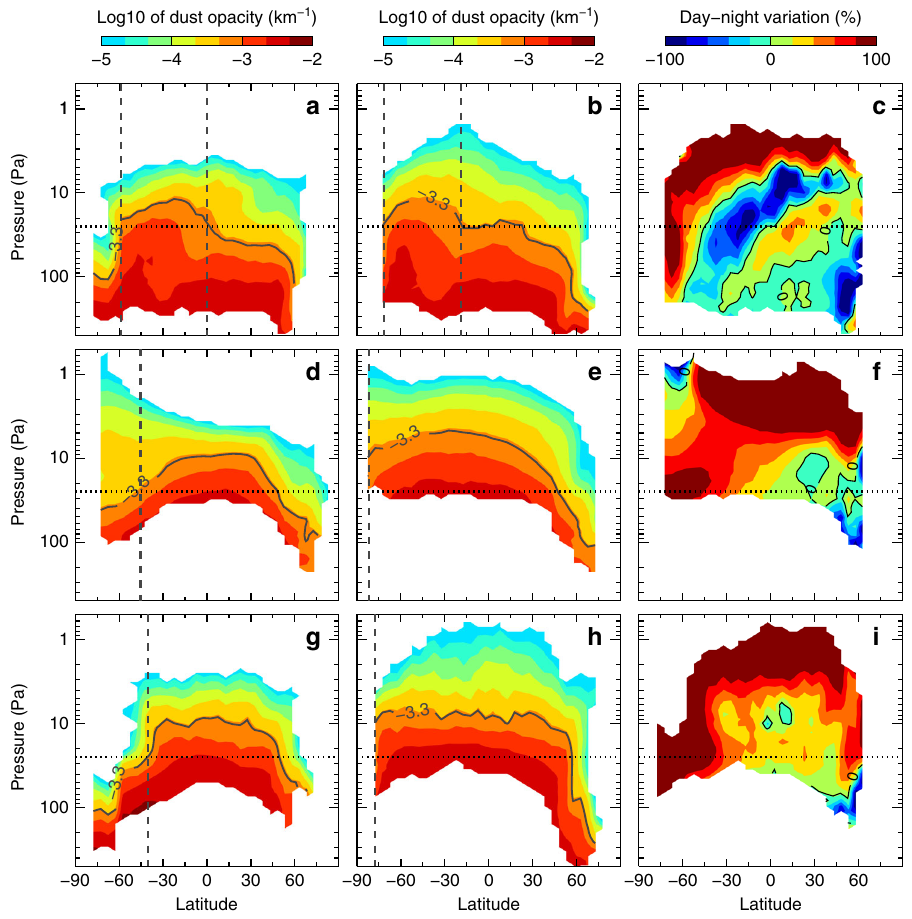
Fig. 3 Meridional and vertical structures of the zonal-mean dust opacity during the peak time of major dust storms. a – c L s = 220 − 221.9° for A-season regional dust storm in MY 33; d – f L s = 270.9 − 272.9° for the global dust storm in MY 28; g – i L s = 206.5 − 208.4° for the global dust storm in MY 34. a , d , g Nighttime at ~3 a.m. (2.5 – 3.5 a.m. averaged). b , e , h Daytime at ~3 p.m. (2.5 – 3.5 p.m. averaged). c , f , i : The relative day – night variations in percentage normalized by the daytime opacity. The L s periods in a – c correspond to the peak time of the dust storm in Fig. 2. For ( a , b , d , e , g , h ), the black solid contour lines indicate the dust height with the opacity of 0.0005. The horizontal dot lines at 25 Pa are used to determine the latitude of the dust front, which is marked by the vertical dash lines. The dust mountain depicts the mountain-like dust distribution between the two dash lines in ( a , b